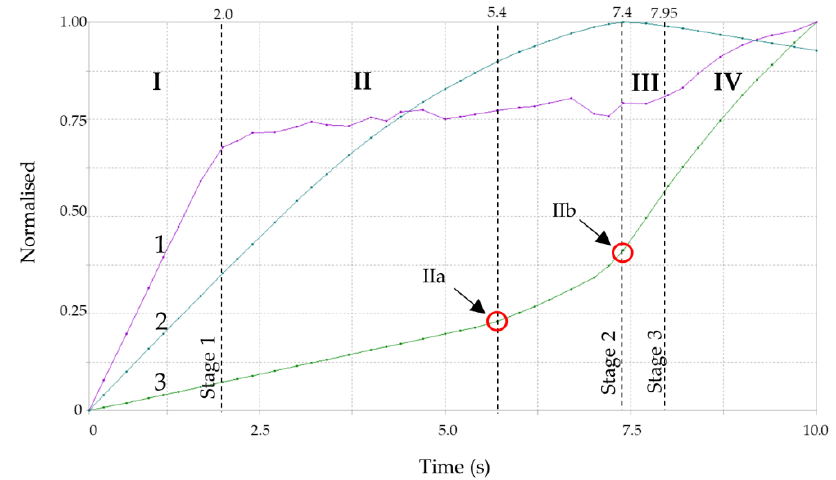
Figure 11. The course of control parameters in numerical calculations. 1—von Mises stress, 2—maximum displacement, 3—force. I, II, III, IV—the element’s work phases as described in Figure 3. Reading of the displacement reference points took place at each load